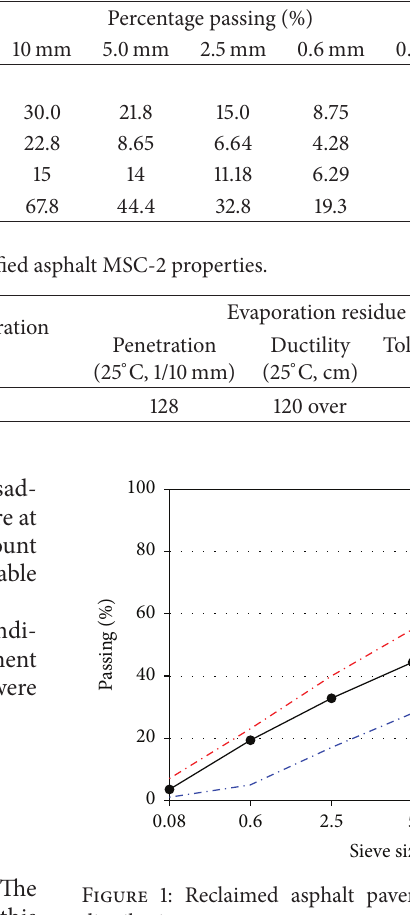
Table 2: Reclaimed asphalt pavement recycled aggregate size distribution.